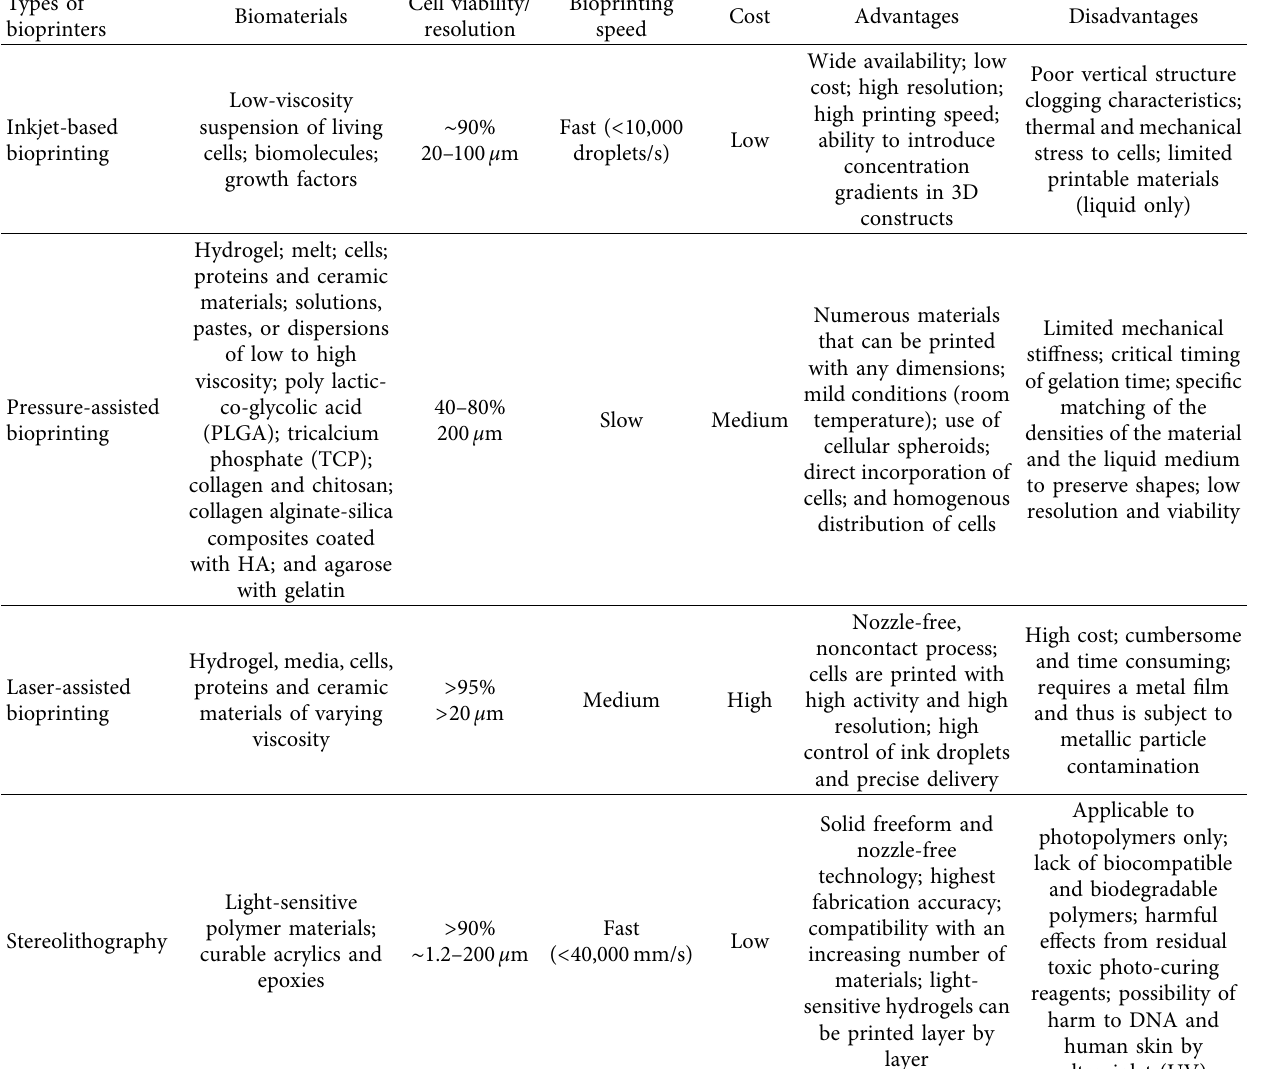
Table 1: Characteristics of 3D bioprinting